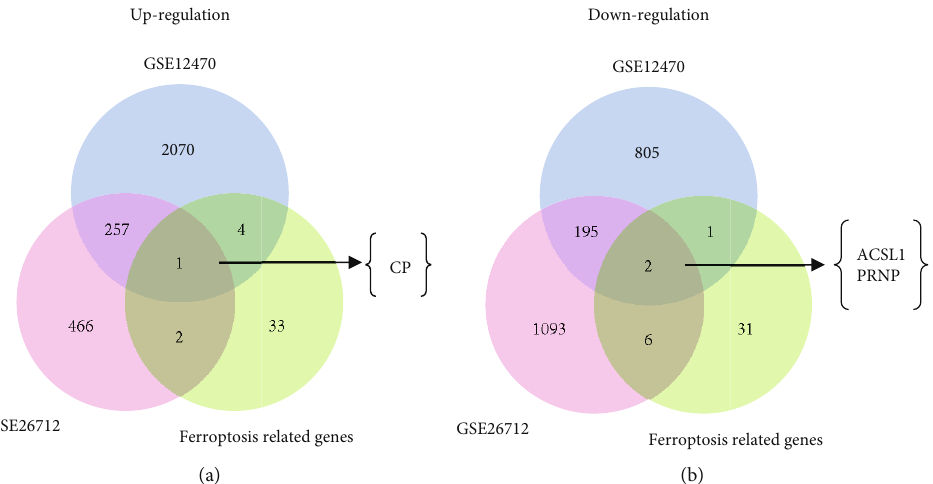
Figure 1: Venn diagrams to ferroptosis-related genes that were di ff erentially expressed in ovarian cancer from microarray datasets. (a) Coincreased expression genes from public ovarian cancer datasets (GSE12470 and GSE26712) were fi ltered together with ferroptosis- related genes to identify the candidate gene CP. (b) Codecreased expression genes from public ovarian cancer datasets (GSE12470 and GSE26712) were fi ltered together with ferroptosis-related genes to identify the candidate genes ACSL1 and PRNP.